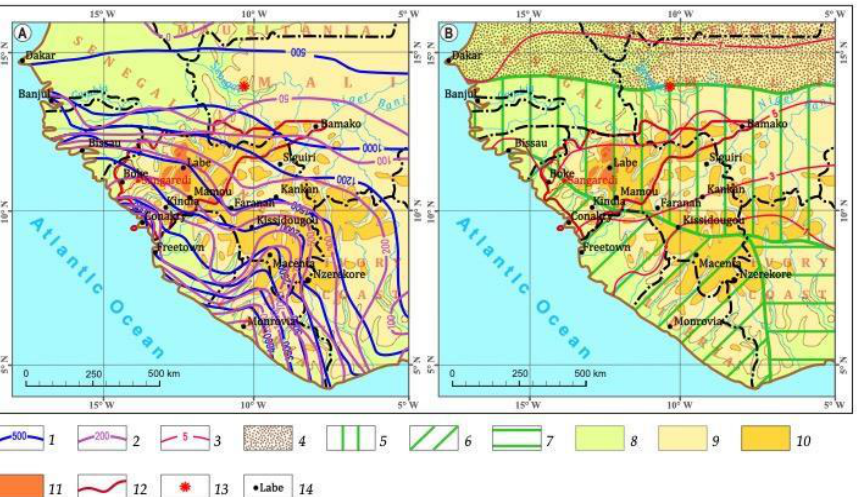
Figure 3. Maps of ( A ) isohyets and isopleths of unevaporated moisture and ( B ) topoclimatic zones and dry period durations, West Africa, based on statistical data at www.climatemps.com, accessed